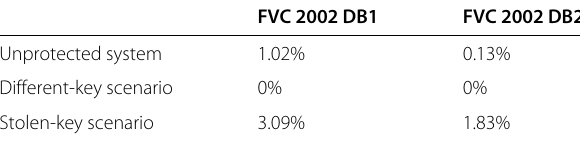
Table 1 The EER values obtained from unprotected system, different-key, and stolen-key scenarios on FVC 2002 DB1 and DB2